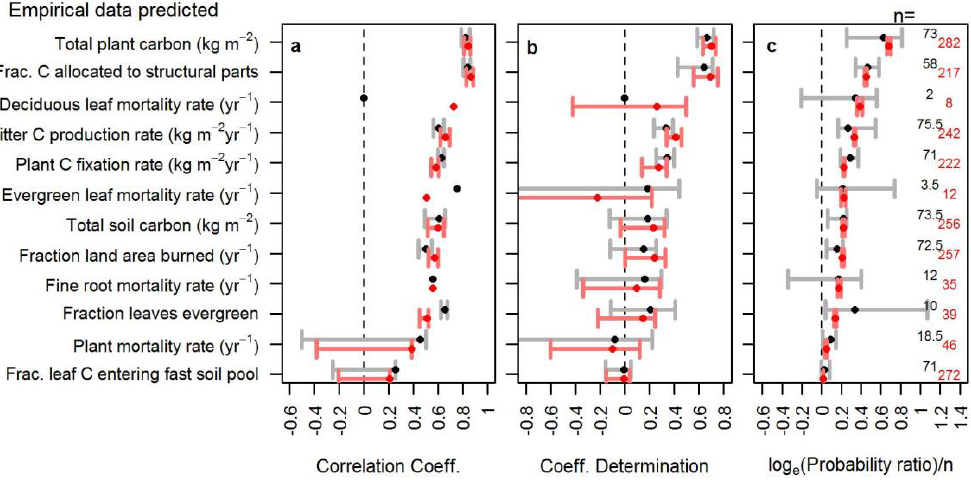
Fig. 4. Performance assessments of the terrestrial carbon model: (a) Pearson’s correlation, (b) the coefficient of determination and (c) the probability of the model relative to a null model (Gelfand and Day, 1994). Separate data subsets were used for parameter inference and Fig. 4| Performance assessments of the terrestrial carbon model. (A) Pearson’s correlation, 1227 model evaluation to avoid over-fitting. A final test data subset was reserved (never used during model development) to provide an independent estimate of the likely predictive ability when the model is applied to locations that have not been observed. Assessments against evaluation (B) the coefficient of determination or (C) the probability of the model relative to a null 1228 and final test data are in grey and red, respectively, with n being the respective mean or absolute number of data points per assessment. Dots and error bars are average medians, 5th and 95th percentiles in (a) and (b) and medians, maxima and minima in (c) using parameter distributions inferred from 10 training data subsets. Insufficient evaluation data existed to calculate (a) and (b) for the deciduous leaf mortality